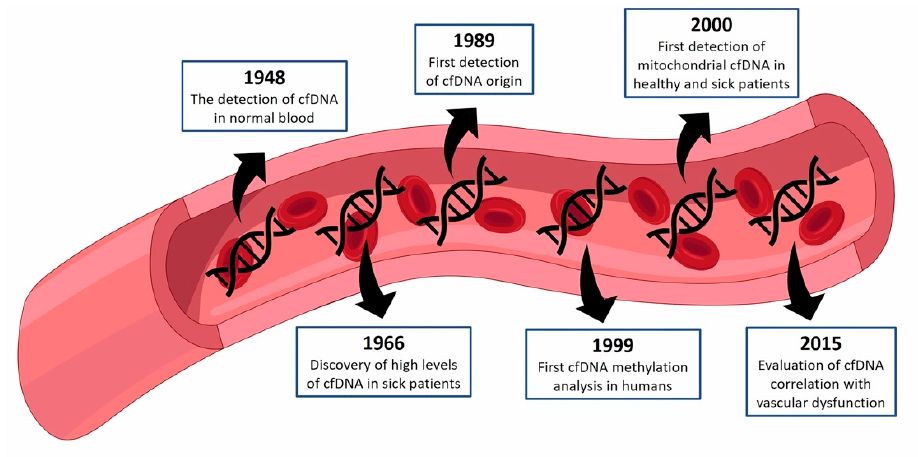
Figure 1. Chronological summary of cfDNA. The timeline shows the main cfDNA discoveries, from the first report in 1948 until the first correlation of cfDNA with vascular dysfunction in 2015. cfDNA: circulating cell-free DNA.